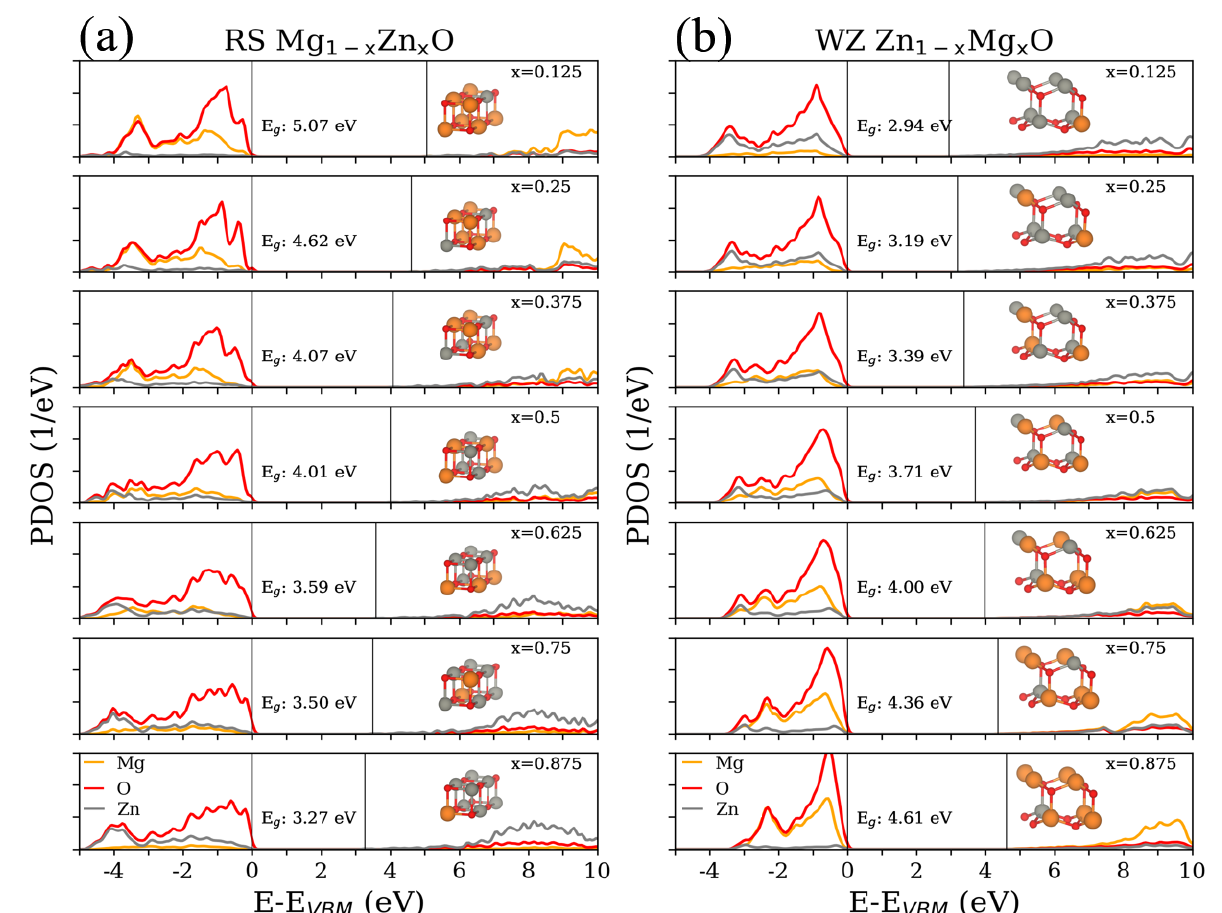
Figure 3. Partial density of states (PDOS) for ( a ) rocksalt (RS) Mg 1 − x Zn x O and ( b ) wurtzite (WZ) Zn 1 − x Mg x O at different concentrations (x = 0.125, 0.25, 0.375, 0.5, 0.625, 0.75 and 0.875) with respect to the valence band maximum (VBM). The colors of orange, red and gray are the PDOS of magnesium (Mg), oxygen (O) and zinc (Zn), respectively. One vertical solid line is the VBM at 0 eV, and the other vertical solid line is the conduction band minimum above 0 eV. The insets inside each panel correspond to the models in Figure